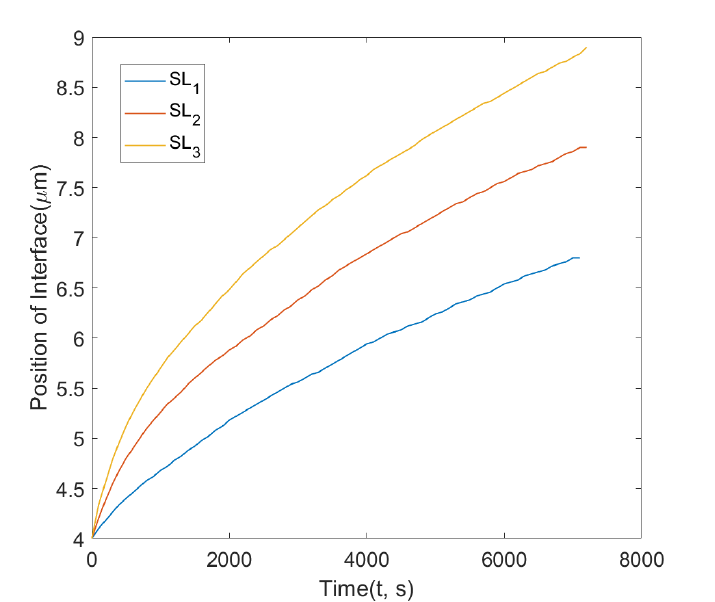
Figure 6. Position of the interface after 2 h for SL 1 , SL 2 , and SL 3 .